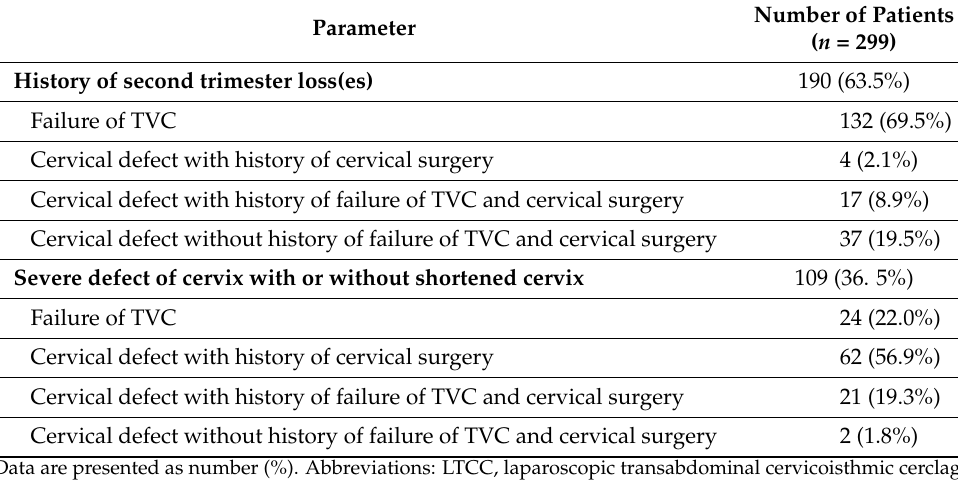
Table 1. Surgical indication of modified